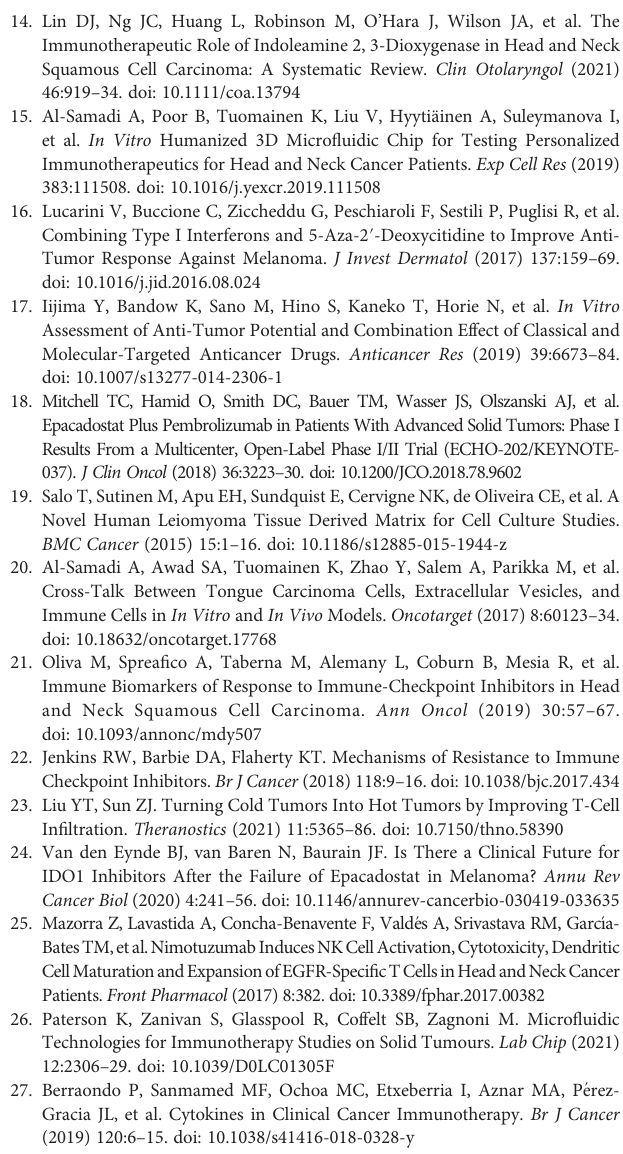
cells in the three-dye system (E) . Subtraction of these cells was considered to yield the number of CD8 + T cells. To provide a clear representation of the migrated cells, the representative image of the cocultures was edited such that the cancer cells are shown in white, CD4 + T cells in blue, and CD8 + T cells in magenta (F). Scale bar A-E 100 µm. Supplementary Figure 4 | Full representation of analyzed channels on day 3 for NK cells, CD4 + T cells, CD8 + T cells, and CD4 + T cells with CD8 + T cells. In the monoculture chip images (A – C) , HSC-3 cells are shown in red, respective lymphocytes(NKcells,CD4 + Tcells,andCD8 + Tcells)inblue,andapoptoticcellsin green. Apoptotic cancer cells appeared yellow due to overlay of red and green colors. In coculture chip images (D) , HSC-3 cells are shown in grey, CD4 + T cells in blue, CD8 + T cells in magenta, and apoptotic cells in green. Scale bar A-D 300 µm. Supplementary Table 1 | Clinical characteristics of the six donors. Supplementary Table 2 | Cytokine concentrations of the conditioned media. Values are in pg/ml. D,